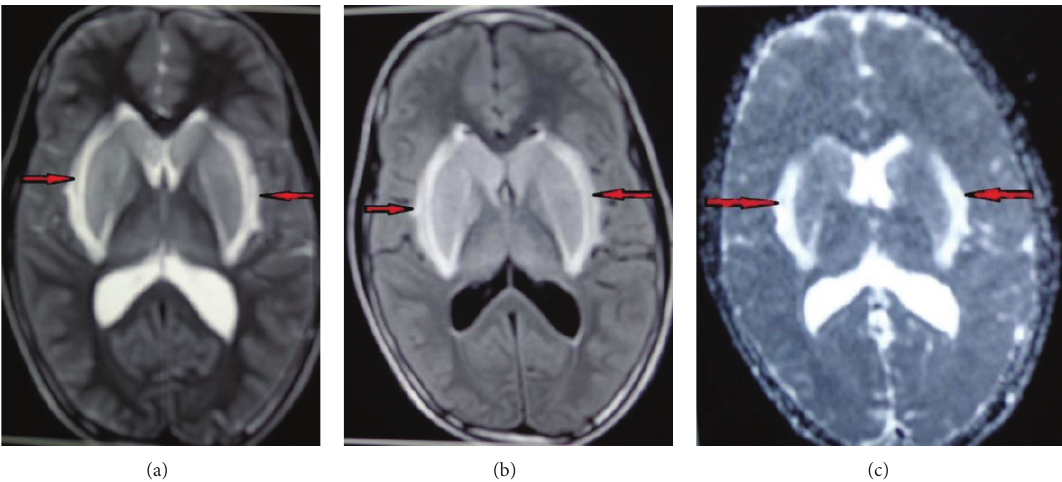
Figure 1: ((a), (b), and (c)) Brain MRI (T1, T2, DWI) showed bilateral basal ganglia are grossly swollen with vasogenic edema tracking along internal capsule and midbrain. Adjacent ventrolateral thalamus and internal capsule also show mild abnormal intensities.